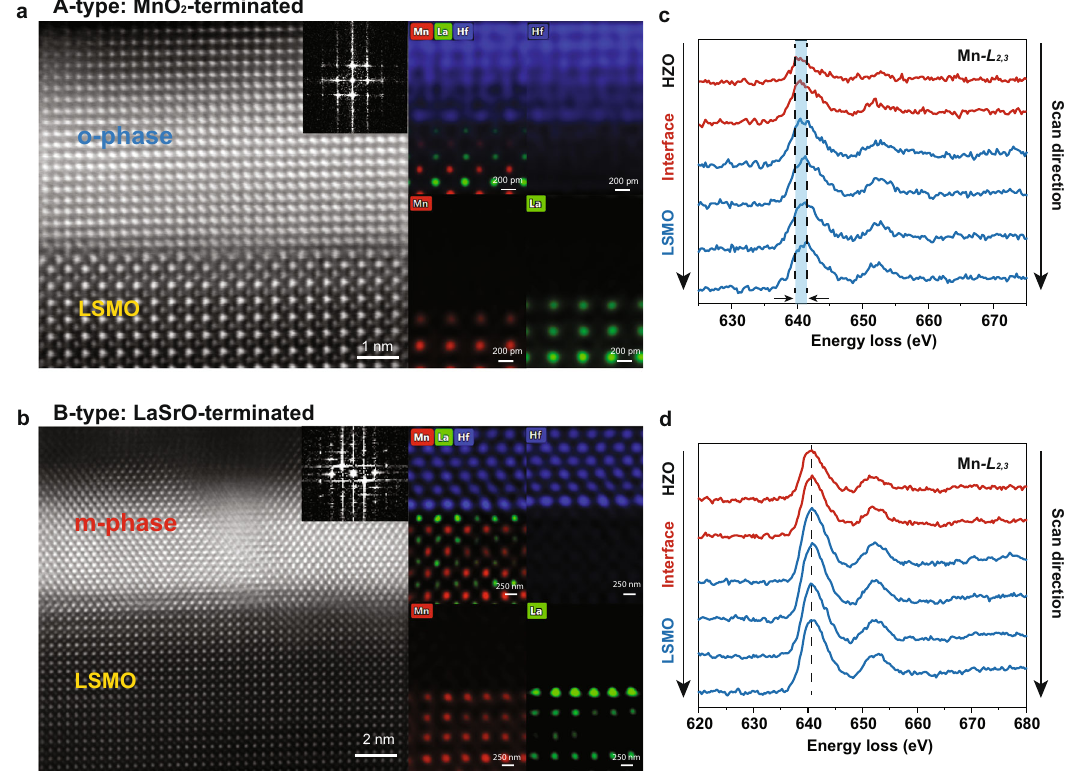
Fig. 2 | HAADF-STEM characterization. a Cross-section image and atomically resolved EDX for A-type heterostructure. b Cross-section image and atomically resolved EDX for B-type heterostructure, which are observed along the [110] zone of the substrate. Mn, La, and Hf atoms in the EDX maps are seen in red, green, and